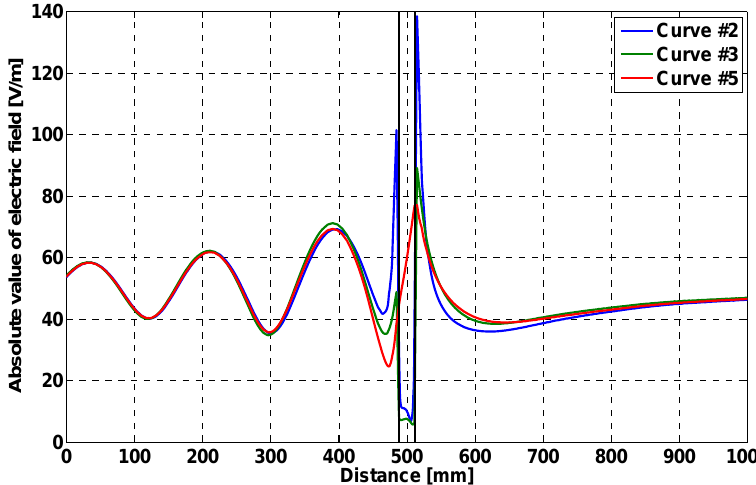
Figure 4. Plane wave field inside and around the bag. The curve number refers to the segments in Figure 2.